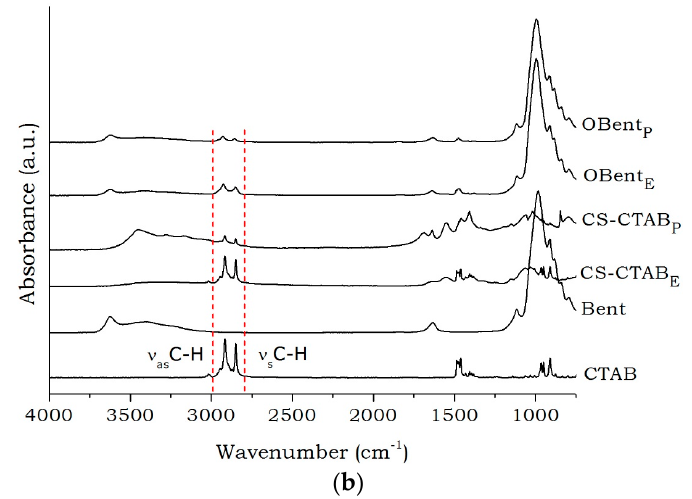
Figure 1. FTIR spectra of ( a ) pure CS and ( b ) CTAB salt, Bent clay, CS-CTAB E , CS-CTAB P , OBent E and OBent P .